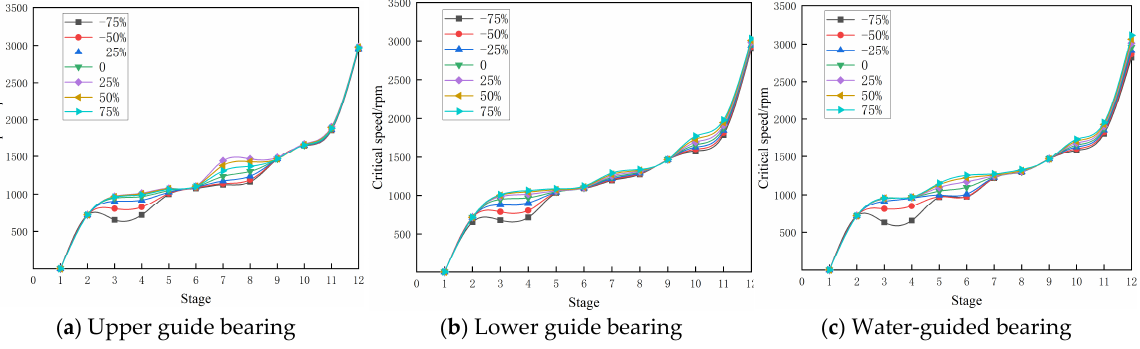
Figure 6. Effect of different stiffness factors of the three guide bearings on the critical speed of the rotor system.